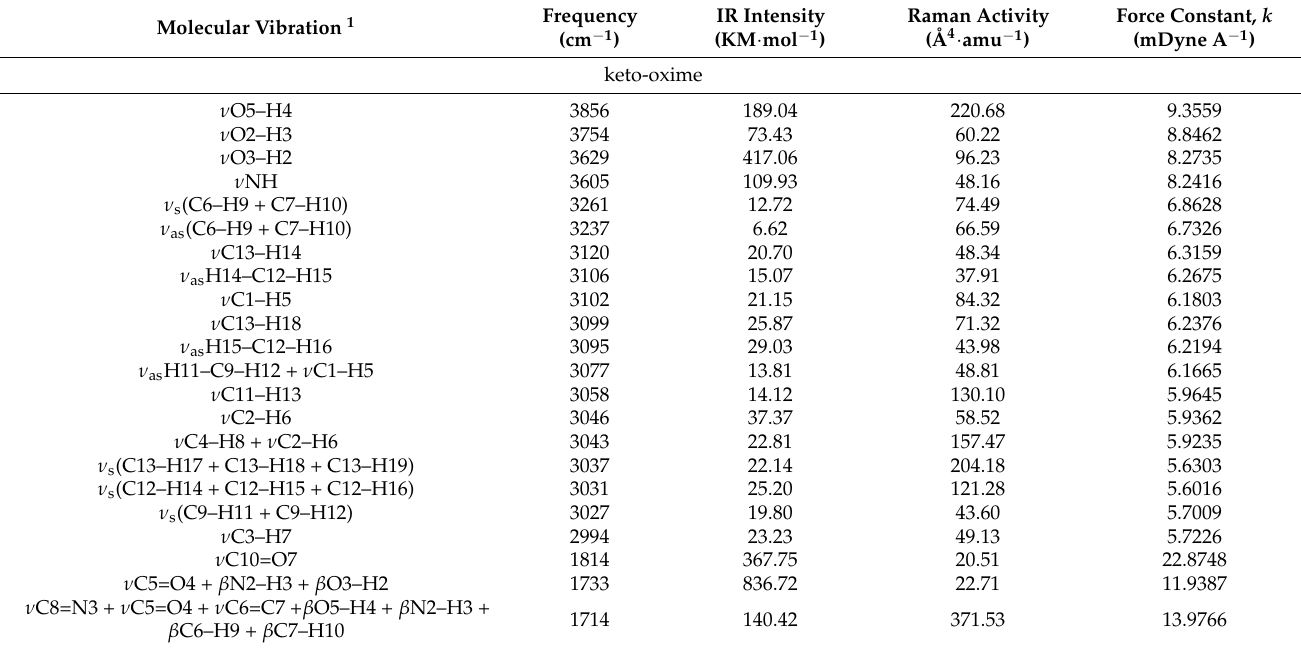
Table 4. Values of the selected vibrations in the calculated IR and Raman spectra (Figure 4) for the optimized structures of the keto-oxime, keto-hydroxylamine, and hydroxyl-oxime tautomers of molnupiravir, obtained by using the DFT/B3LYP/6-311++G(d,p) method. Molecular Vibration